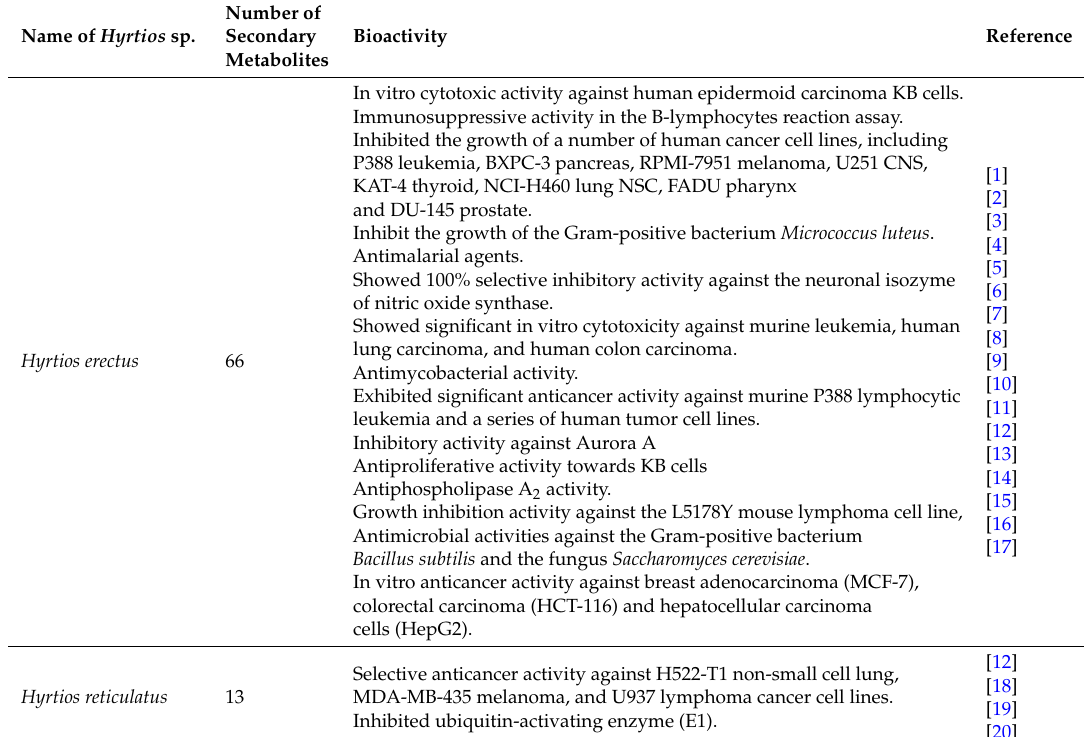
Table 1. Secondary metabolites isolated from marine sponges from the genus Hyrtios .